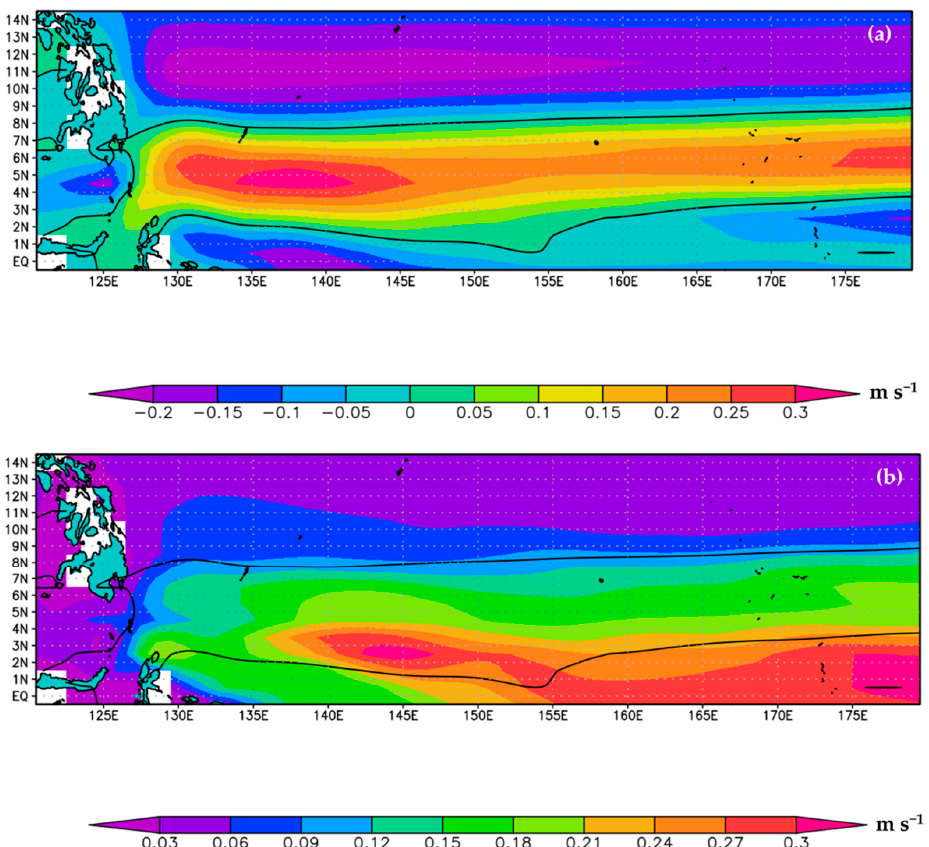
Figure 3. Average plot of zonal velocity of ORAS5 ( a ) and its related standard deviation ( b ) from January 1978 to December 2017. The positive and negative numbers in ( a ) represent the eastward and westward currents, respectively.